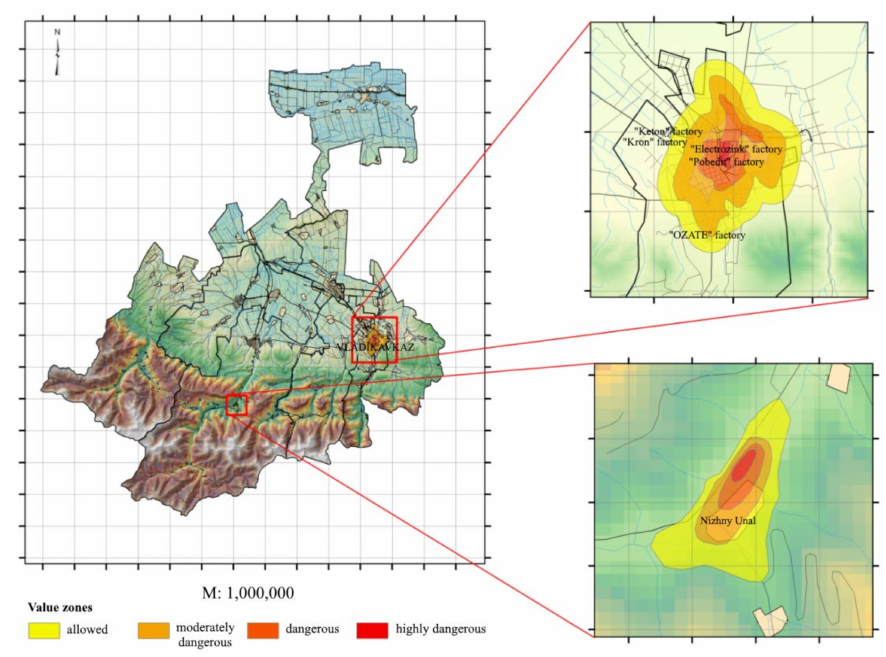
Figure 2. Map-scheme of areas of ecological situations in the mining regions of North